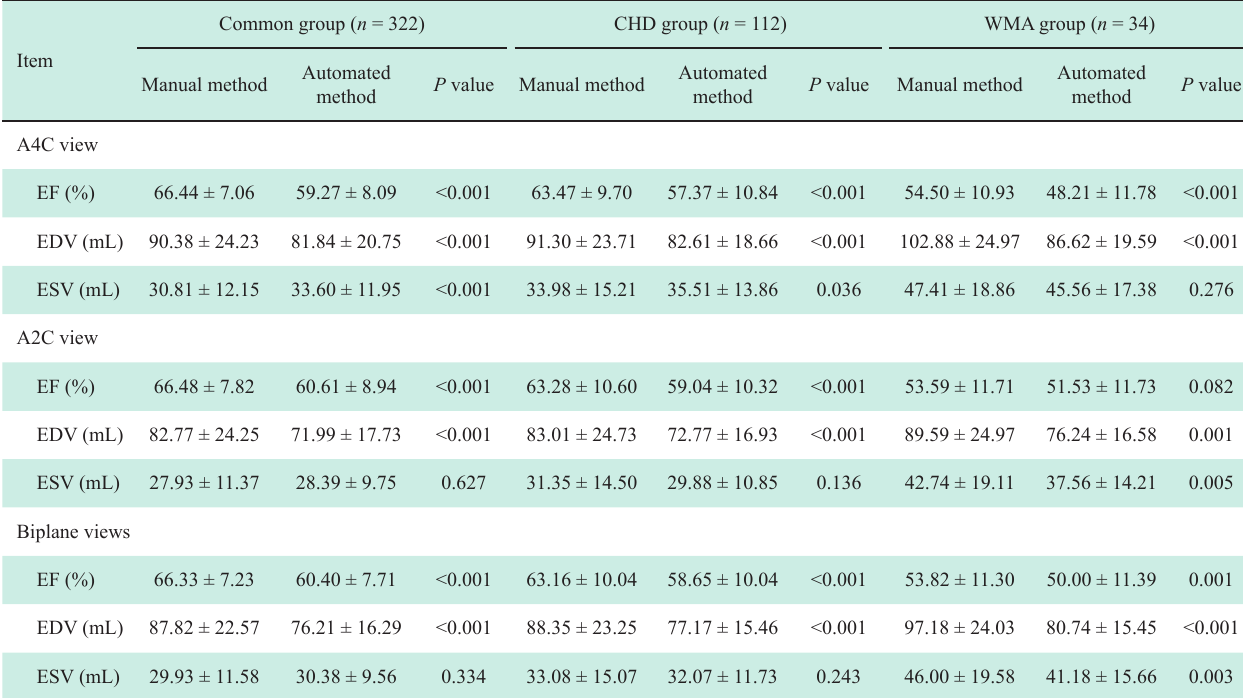
Table 2 Echocardiographic left ventricular systolic function